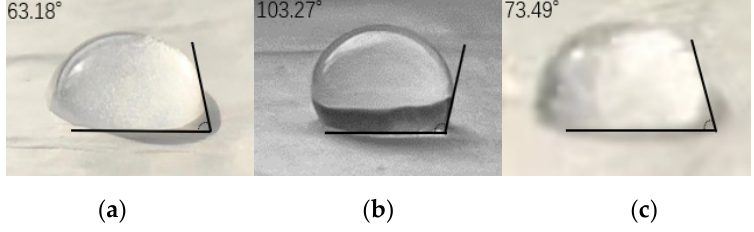
Figure 3. Contact angle diagram of samples, ( a ) PAN, ( b ) PLLA, ( c ) PAN + PLLA.